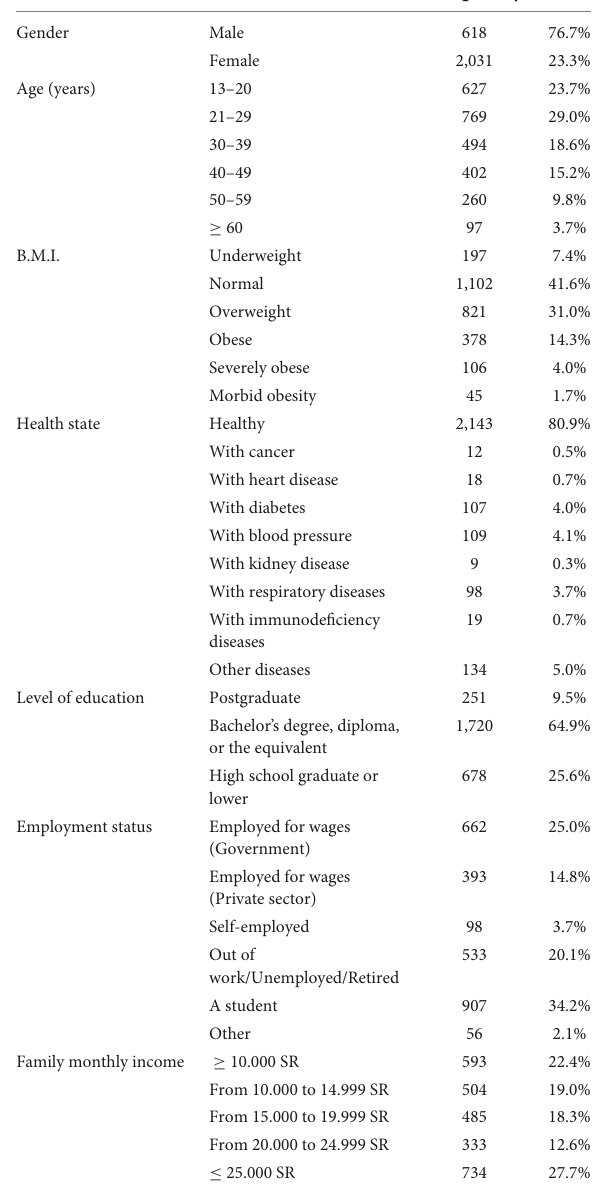
TABLE 1 Demographic characteristics of the